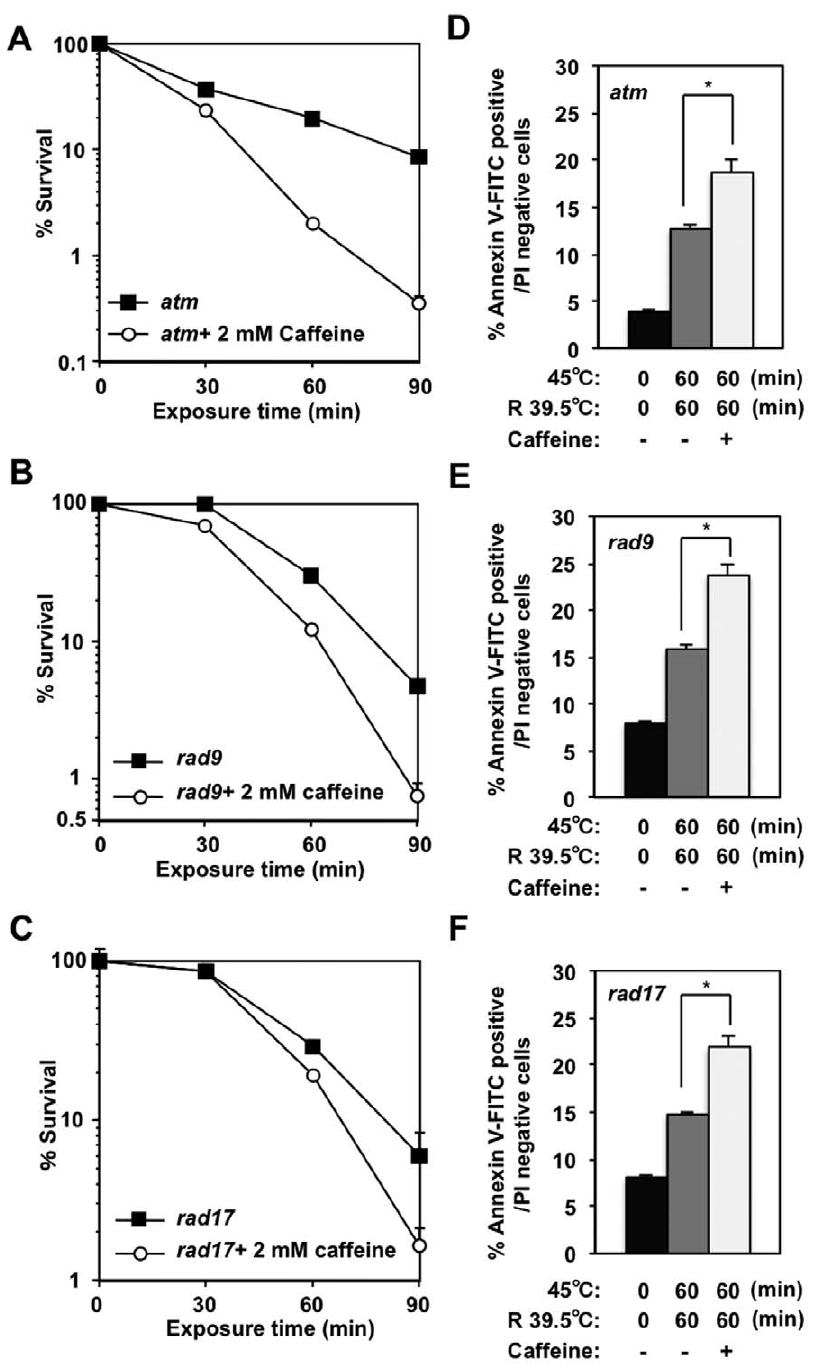
Figure 6. Caffeine enhanced the heat cytotoxicity of rad9,rad17 or atm DT40 cells. A–C. Clonogenic survival. atm ( A ), rad9 ( B ) and rad17 ( C ) DT40 cells were cultured at 45 u C for the indicated time in the presence or absence of 2 mM caffeine. D–F. Apoptosis. atm ( D ), rad9 ( E ) and rad17 ( F ) DT40 cells were cultured at 45 u C for 60 minutes and at 39.5 u C for 60 minutes in the presence or absence of 2 mM caffeine. ( D ) * p= 0.0012, ( E ) * p= 0.0057, ( F ) * p= 0.0084 (Student’s t